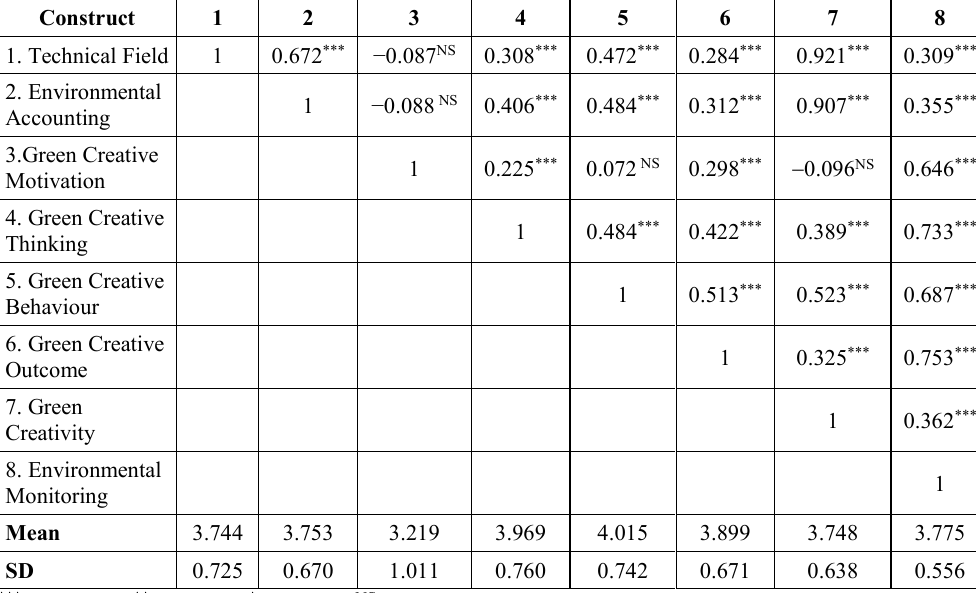
Table 4. Descriptive Statistics and Bivariate